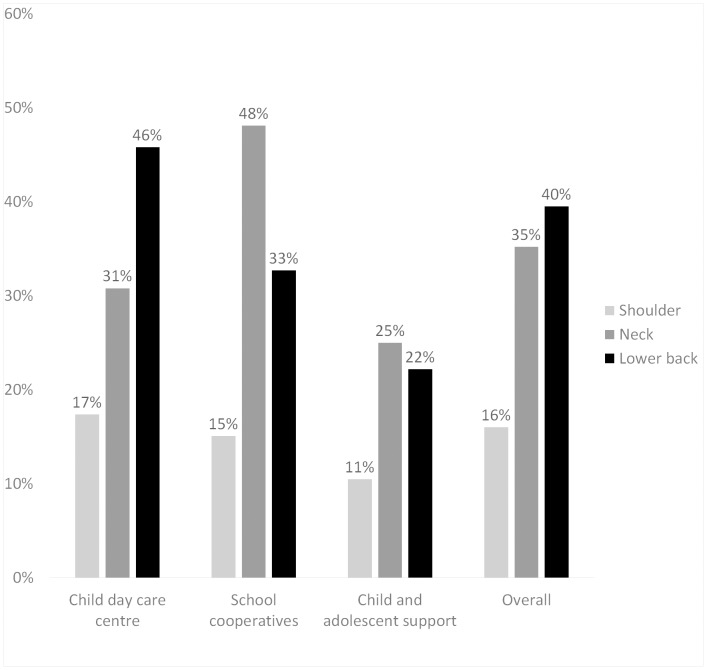
Prevalence of musculoskeletal symptoms.